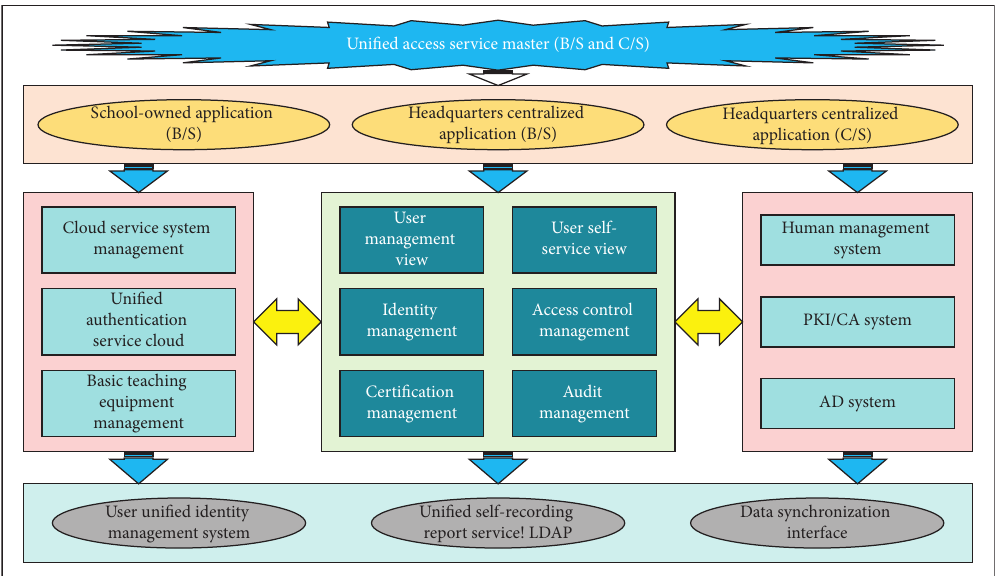
Figure 4: Network